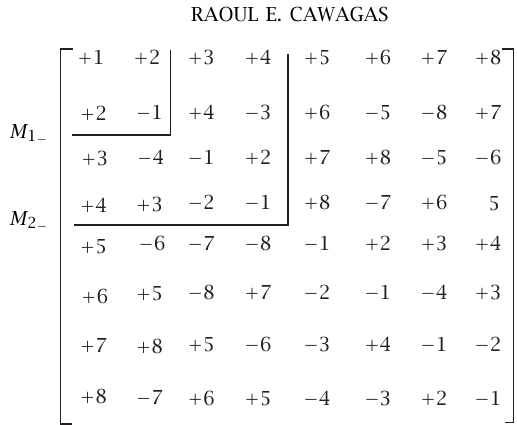
= e ⊗ e = z i j ij e k